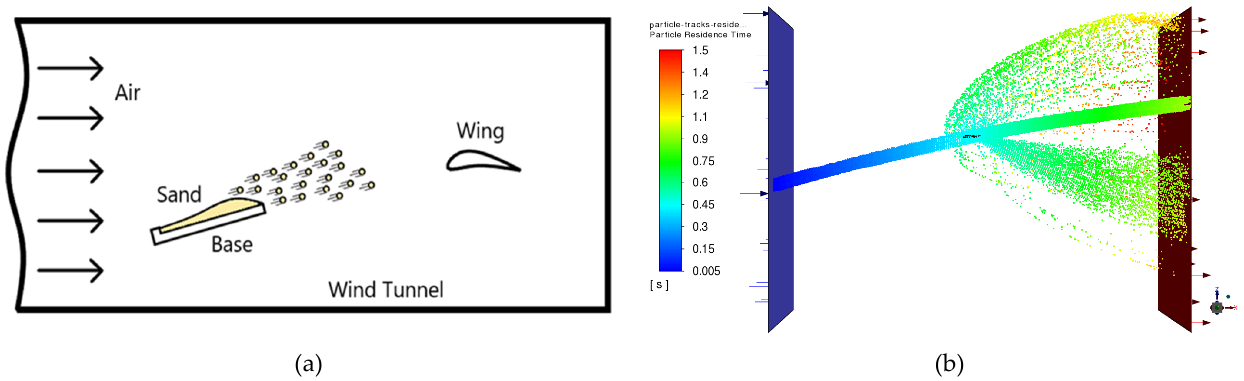
Figure 8. ( a ) Schematic view diagram of the air–solid flow experiment ( b ) Solid particles tracks and residence time during two-phase flow simulation. residence time during two-phase flow